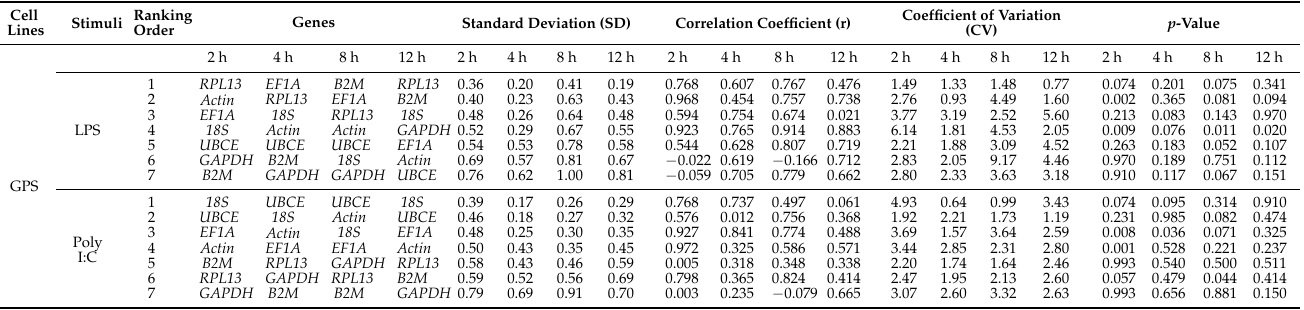
Table 8. The expression stability of housekeeping gene candidates in GPS and GPHK cells under stimulation with LPS or Poly I:C for 2, 4, 8 and 12 h, as assessed by BestKeeper